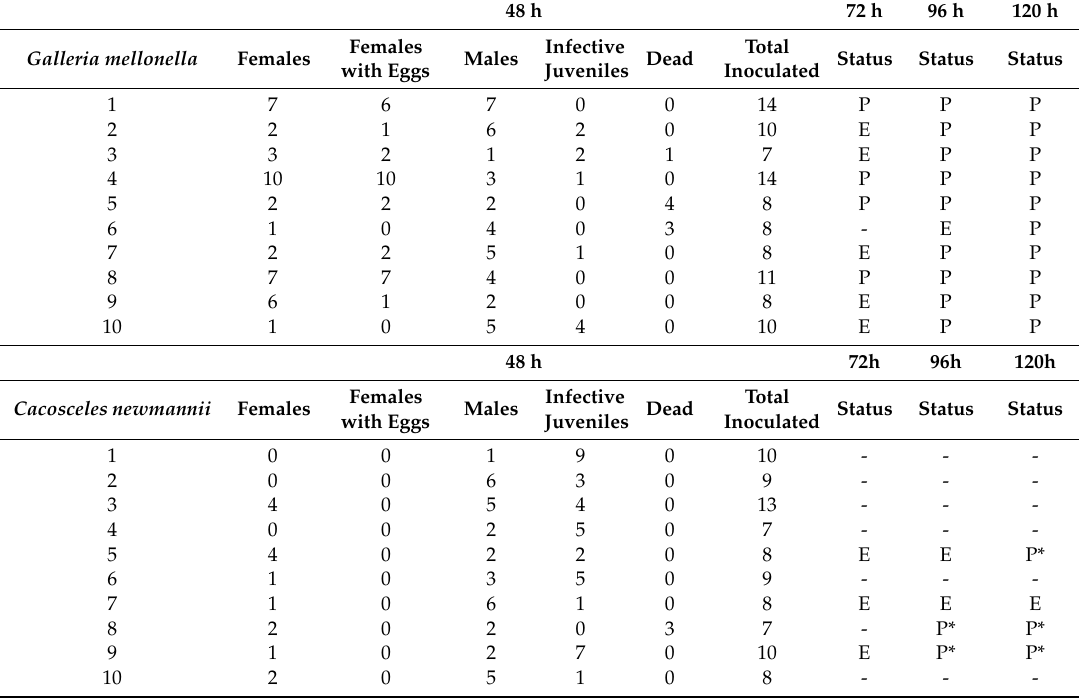
Table 4. Number of females, males, IJs, and dead Steinernema je ff reyense 48 h after inoculation in the haemolymph, and status of the nematodes (P = progeny, E = females with eggs) 72, 96 and 120 h after inoculation. * indicate a peculiarly low level of